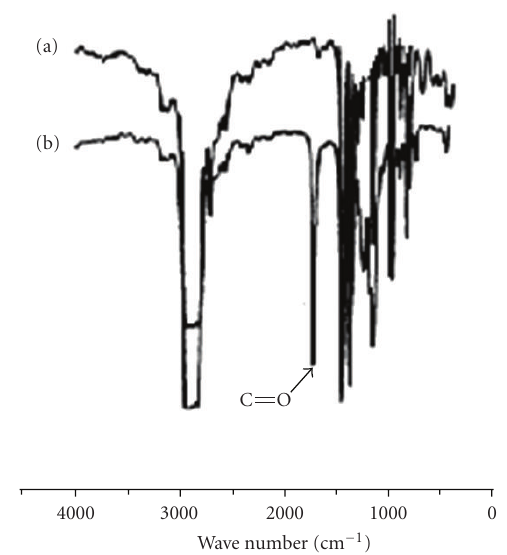
perfluro-2-ethanol acrylic monomer onto poly (ethylene terephthalate) (PET) [10] and for grafting perflouro-2- ethanol acrylic monomer/stearyl methacrylate monomer mixture on PET fibers